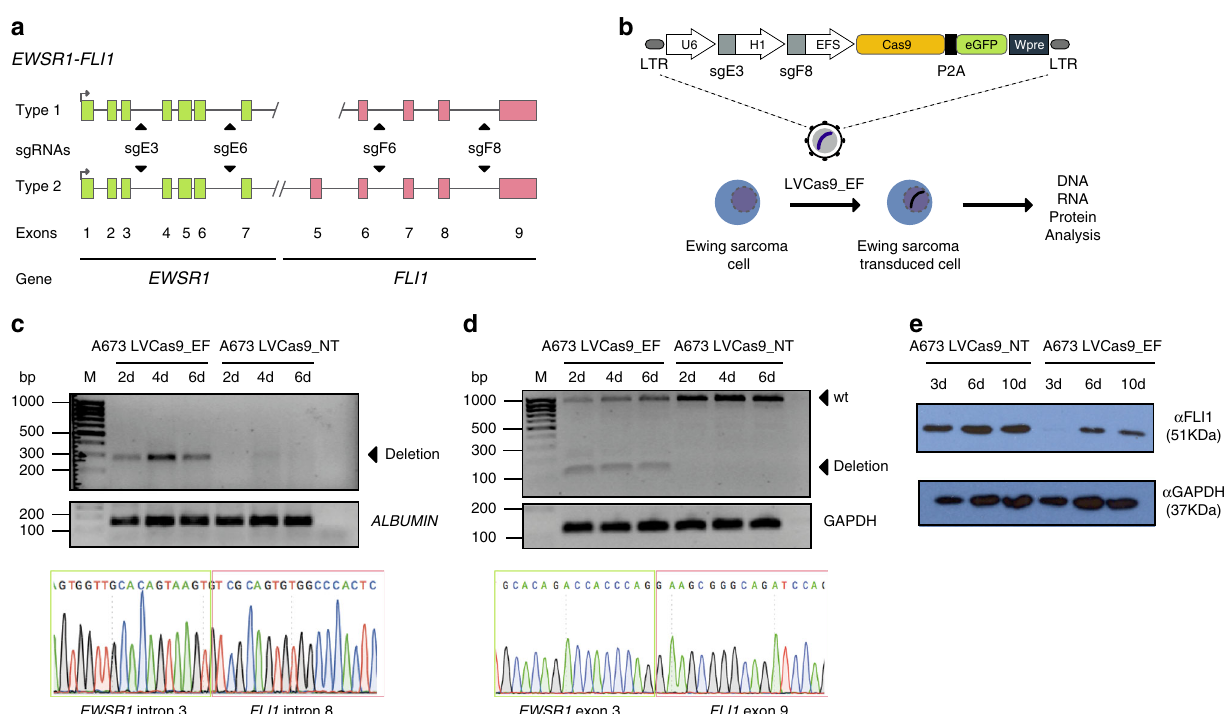
Fig. 1 Strategy and in vitro CRISPR-mediated disruption of EWSR1-FLI1 . a Scheme representing type 1 and 2 EWSR1-FLI1 FOs, illustrating the genomic structure with exon arrangement and sites of fusion. sgRNAs targeting introns 3 and 6 of EWSR1 and 6 and 8 of FLI1 are indicated. b Schematic representation of the all-in-one lentiviral vector for simultaneous expression of two sgRNAs, Cas9 and eGFP regulated by the U6, H1, and EFS promoters. c , Genomic PCR analysis of edited and control A673 cells using oligonucleotides fl anking the DNA targeted by sgE3 and sgF8 ( n = 3, independent studies). The 300 bp PCR product denotes deletion of the DNA fragment between the loci targeted by sgE3 and sgF8. PCR analysis was performed on extracted DNA of cells at day 2, 4, and 6 post-transduction (pt). ALBUMIN was used as an internal control of the PCR reaction. Bottom panel shows a representative Sanger sequencing chromatogram of the PCR products. d RT-PCR products from edited and control A673 Ewing sarcoma cells ( n = 3, independent studies). Analysis was done using extracted RNA of cells at day 2, 4, and 6 pt. Arrows depict the sizes of wild-type (961 bp) and deleted (150 bp) RT-PCR products. GAPDH was used as an internal control of the RT-PCR reaction. Bottom panel shows a representative Sanger sequencing chromatogram of RT- PCR products. e Western blotting of EWSR1-FLI1 in A673 cells. Analysis was done using total protein extracted from cells at day 3, 6, and 10 post- transfection using an antibody speci fi c for FLI1. GAPDH was used as an internal control of the assay. LTR: Long term repeat; P2A: porcine teschovirus-1 2A self-cleaving peptide; WPRE: Virus (WHP) posttranscriptional regulatory signi fi cantly blunted clonogenic capacity (51%, 62%, 49%, and (Supplementary Table 1) revealed a PCR band veri fi ed by Sanger 56%, respectively) irrespective of the sgRNA pair used (Supple- sequencing both in A673 cells (Fig. 1c) and in RD-ES cells (Supplementary Fig. 2c). Consistently, RT-PCR and western blot analysis con fi rmed that the simultaneous expression of sgE3 and sgF8 induced a robust loss of EF mRNA and protein, respectively (Fig. 1d, e and Supplementary Fig. 2d). We designed a quanti- tative qRT-PCR-based expression assay for FO to estimate rates of deletion, and found a signi fi cant 4.5-fold decrease in FO expression in edited A673 cells at day 3 post-transduction (p.t.) (Supplementary Fig. 2e). Deep sequencing of the deletion PCR amplicons indicated a preference (~60%) for precise ligation of cut products (Supplementary Fig. 2f). Finally, targeted deep- sequencing analysis revealed that EF-targeted human primary mesenchymal stem cells (hMSC) cells perform accurate splicing of EWSR1 exons. To rule out any possible bias in the use of a non-targeting control, we also tested a second control plasmid (LVCas9_dC1/2) targeting two unrelated genomic loci that gen- erate two genomic DSB in two different chromosomes. Results showed no changes to cell viability in transduced A673 cells (Supplementary Table 1 and Supplementary Fig. 2g).